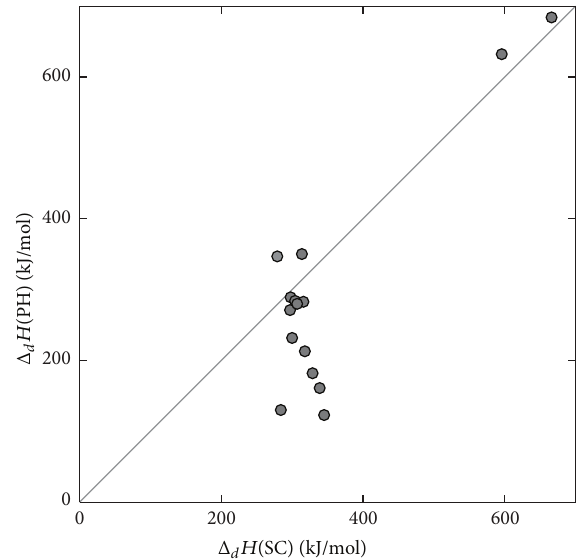
Figure 4: DSC decomposition enthalpies: PH versus SC values.